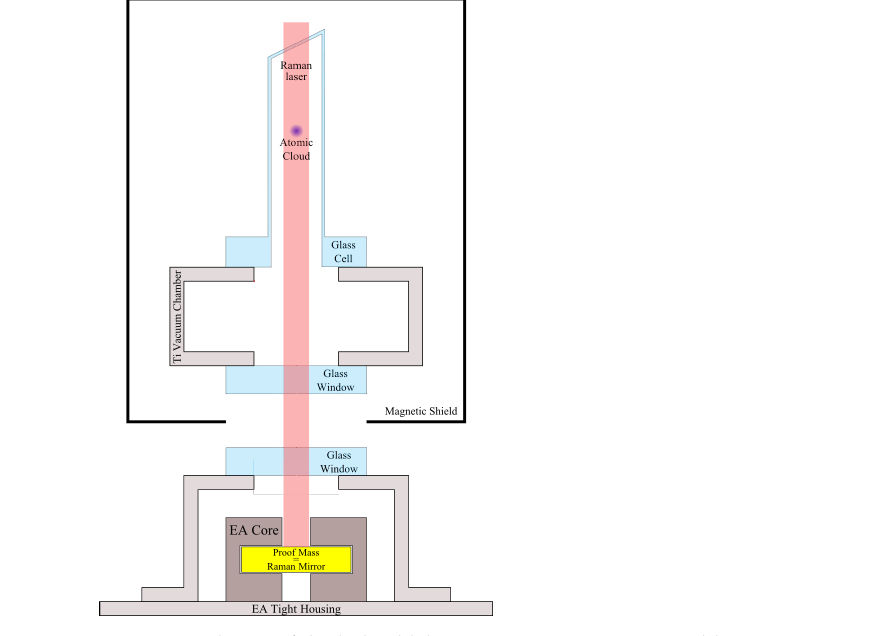
Figure 7. Scheme of the hybrid lab prototype comprising a cold atom gravimeter and an electrostatic accelerometer. In this configuration, the proof-mass of the EA acts as the retro-reflecting Raman mirror, the reference mirror for the CAI